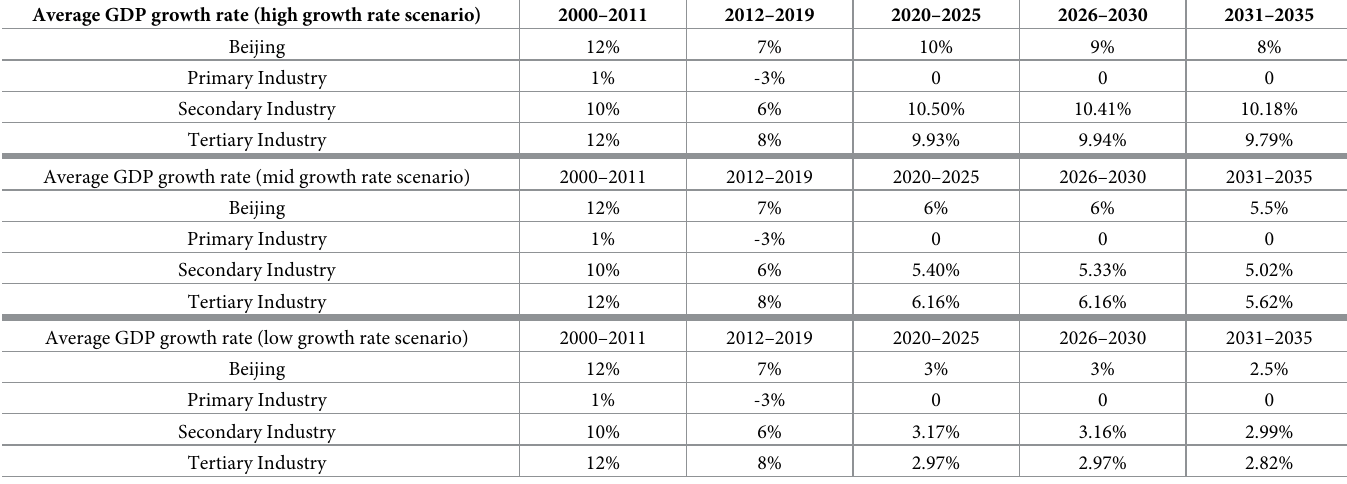
Table 3. GDP growth rate of various industries and stages. Average GDP growth rate (high growth rate